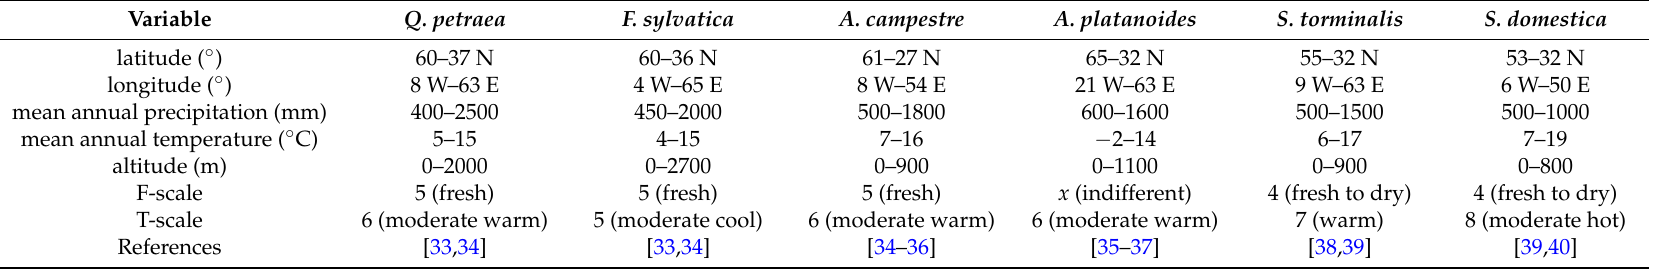
Table 1. Overview of basic biogeographical information on the studied tree species. F-scale (moistness) and T-scale (temperature) abbreviate the indicator values [32]. For Acer platanoides , only the European provenances are